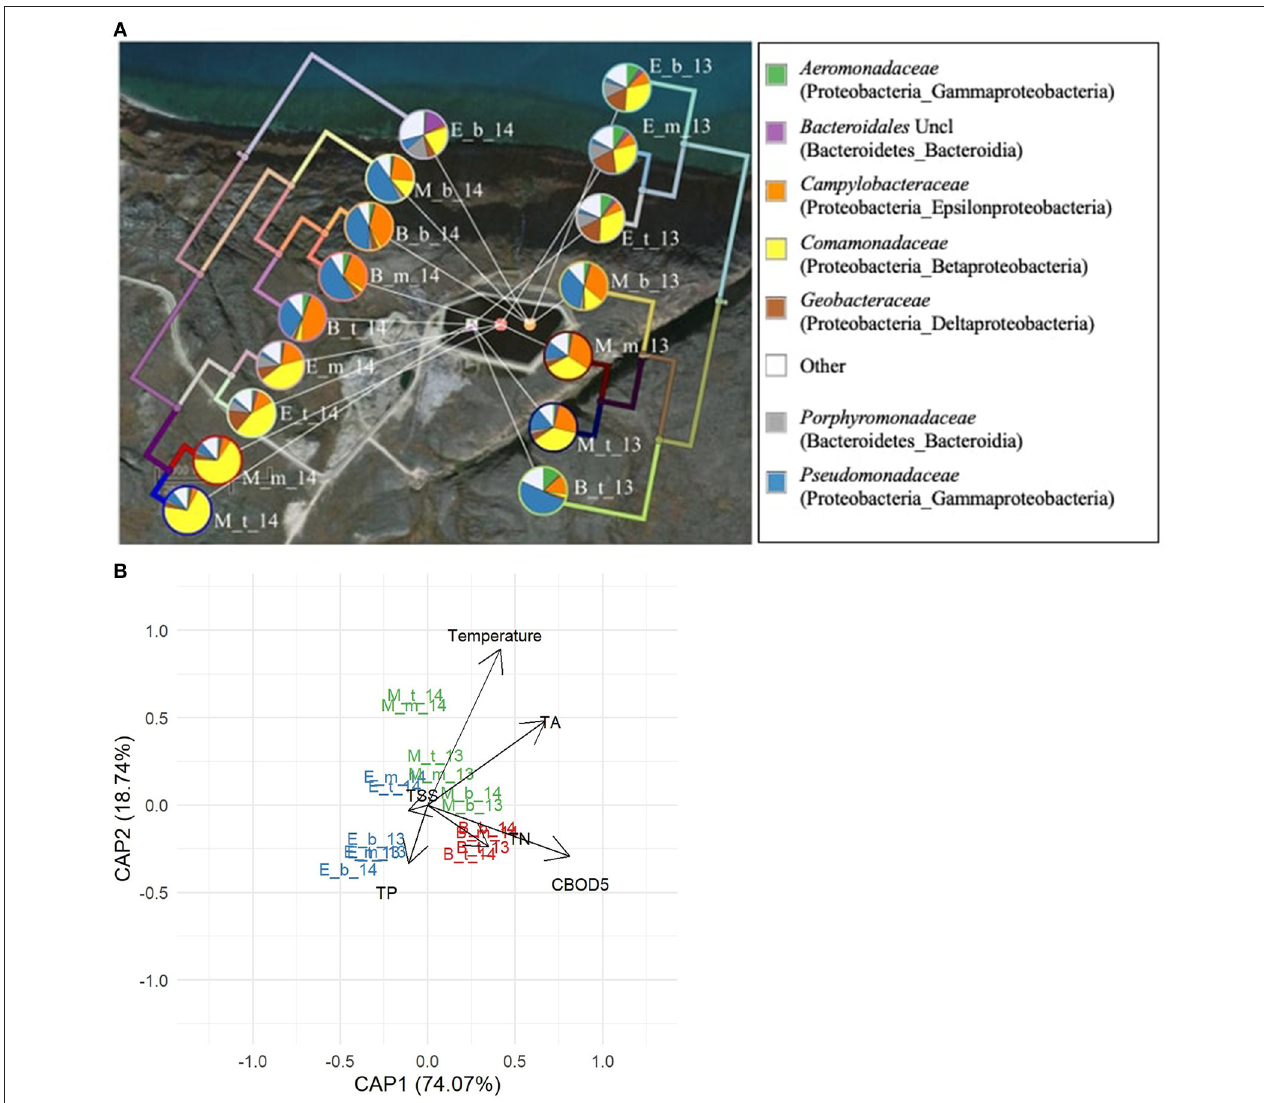
FIGURE 5 | Bacterial communities in the Pond Inlet WSP during the 2013 (right side) and 2014 (left side) treatment seasons. (A) The seven most abundant families (relative abundances ≥ 10% among 269 bacterial families) are presented in the pie charts. The UPGMA tree shows the bacterial phylogenetic beta-diversity (weighted UniFrac metric) in each sampling year. Legends beside the pie charts: B – Beginning, M – Middle, E – End of summer treatment season; t: top, m: middle, and b: bottom sampling depths in the WSP, respectively. The legend (right) denotes the bacterial families with the phylum and class names in brackets. Uncl: unclassified. Other: sum of bacterial families with relative abundances below 10%. (B) Distance-based RDA plot showing the relationship between temperature, water quality measures and the seasonal and annual phylogenetic bacterial beta-diversity in pond samples. Significant factors ( p < 0.01) were temperature, CBOD 5 and TP.